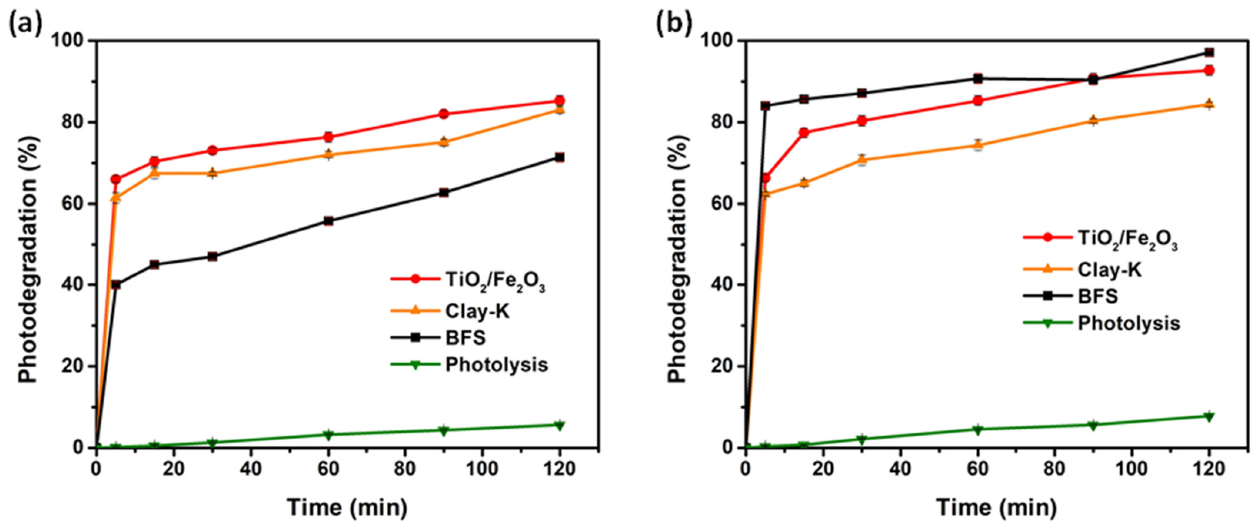
Figure 14. Cyanide degradation kinetics: ( a ) 400–600 Wh/m 2 and ( b ) 600–800 Wh/m 2 . Effect of solar irradiance; 2 g/L catalyst.